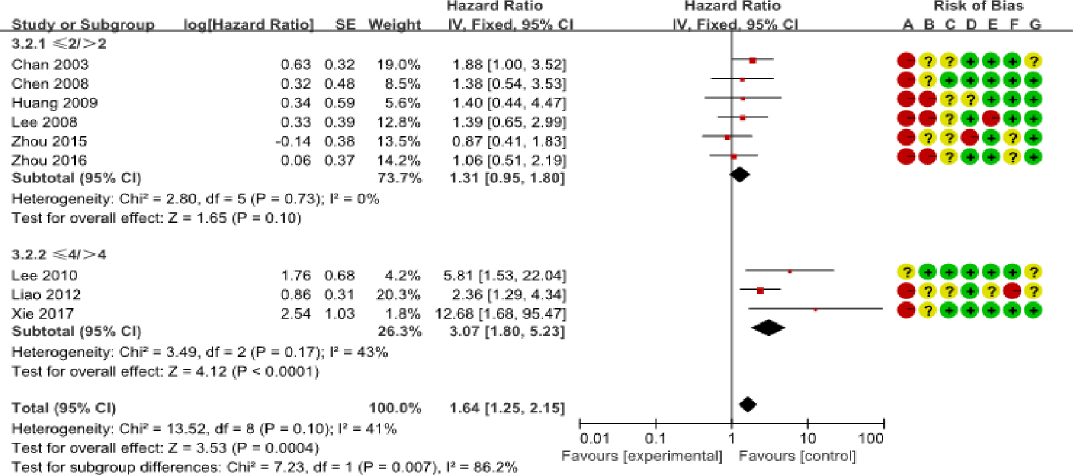
Fig 3. Tumor size. Forest plot of tumor size and overall survival of small cell carcinoma of the cervix patients. SE: standard error; CI: confidence